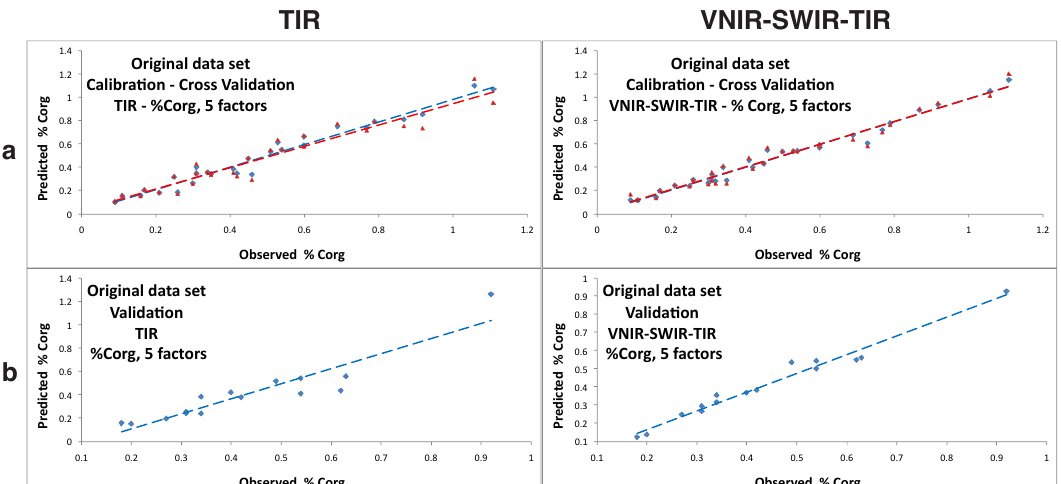
Figure 8. Observed (reference) organic carbon content versus organic carbon content predicted from the PLSR models for the TIR and the VNIR-SWIR-TIR spectral regions. ( a ) calibration (red) and internal cross-validation (blue); ( b ) external validation using a test dataset (blue) for the original